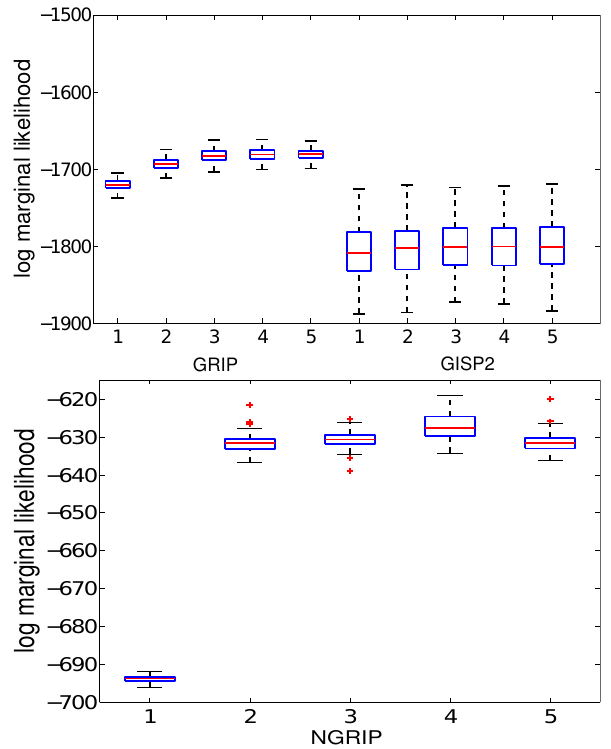
Fig. 3: Marginal likelihoods for the ensemble derived from each data set for models with 1–5 states. The red line indi- cates the median of the ensemble, the box is the 25 and 75 percentiles, the whiskers are the maximum and minimum of the distribution while the red markers indicate outliers.